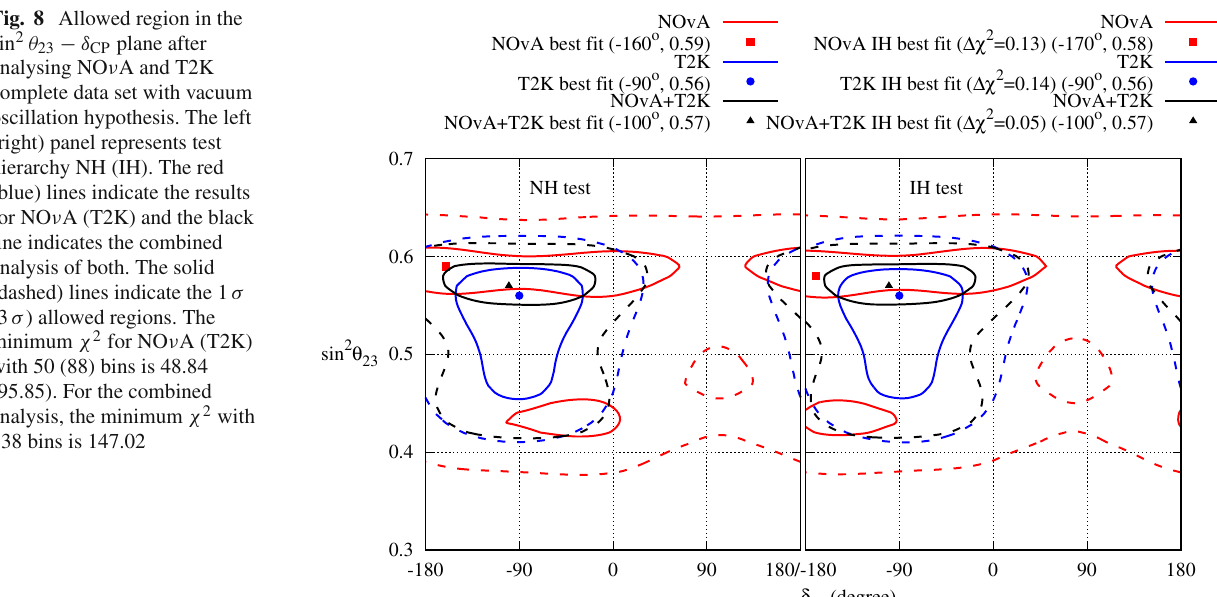
Table 2 Best-fit values of NO ν A and T2K for different modes. The best-fit values have been presented as hierarchy-sin 2 θ 23 - δ CP . For vacuum oscillation hypothesis, we did not mention the hierarchy, as vacuum oscillation cannot distinguish between the two hierarchies